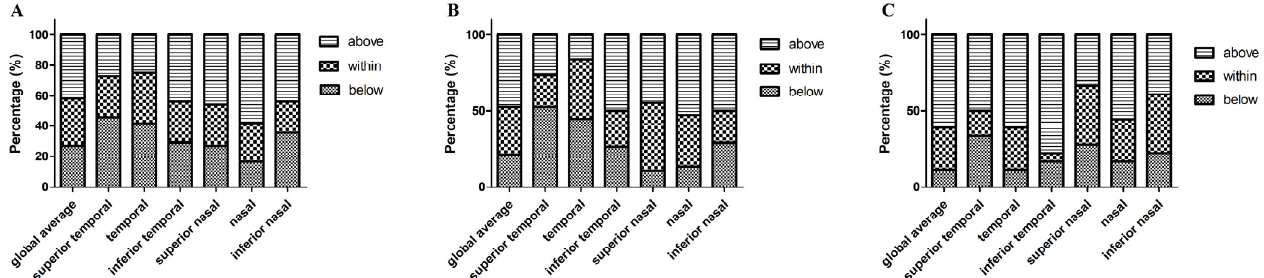
Figure 6. The percentage of pRNFL thickness (diameter of 3.5 mm) below, within, and above 95% confidence interval (according to the controls) in PD, MSA, and PSP groups. ( A ) Parkinson’s disease; ( B ) MSA, multiple system atrophy; ( C ) PSP, progressive supranuclear palsy. Abbreviations: pRNFL, peripapillary retinal nerve fiber layer.